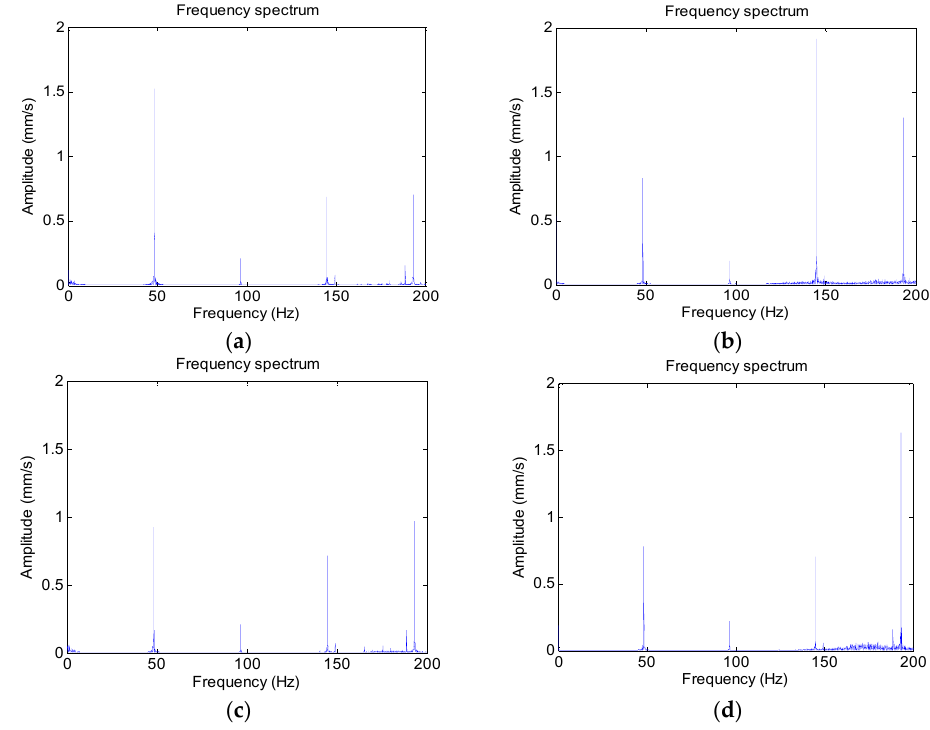
Figure 11. Frequency spectrum of each operating condition; ( a ) Condition 1; ( b ) Conditon